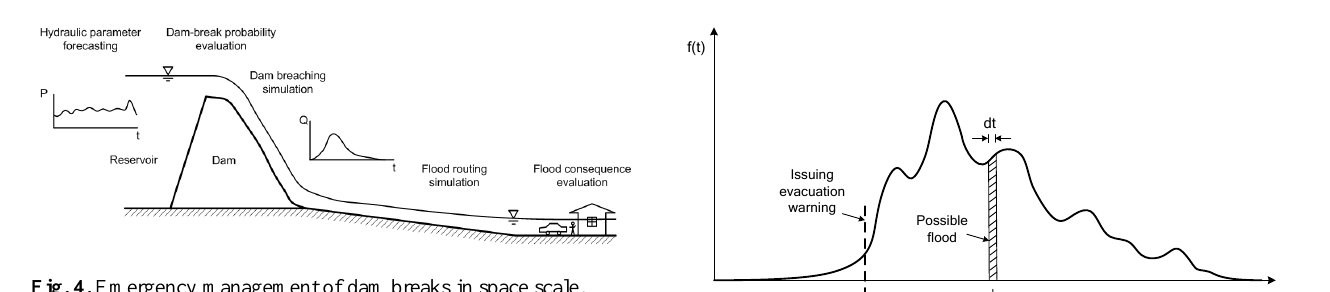
Fig. 4. Emergency management of dam breaks in space scale. reservoir water elevation exceeds the elevation of the dam crest. The probability of dam failure is closely related to hy-